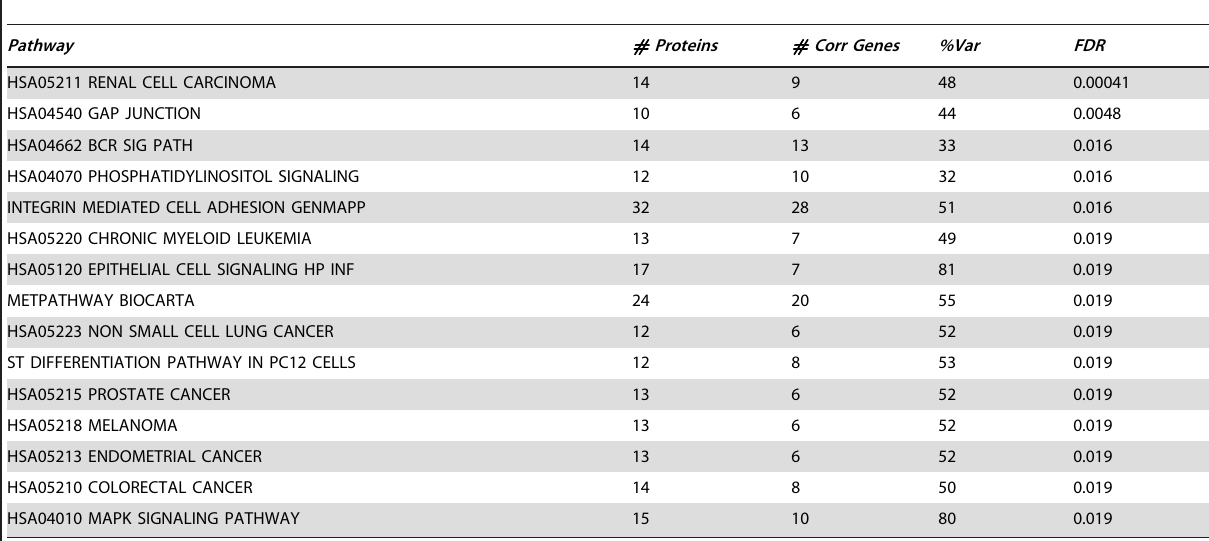
Table 3. The top 15 protein-sets from MSigDB C2 database for normal/tumor classification.